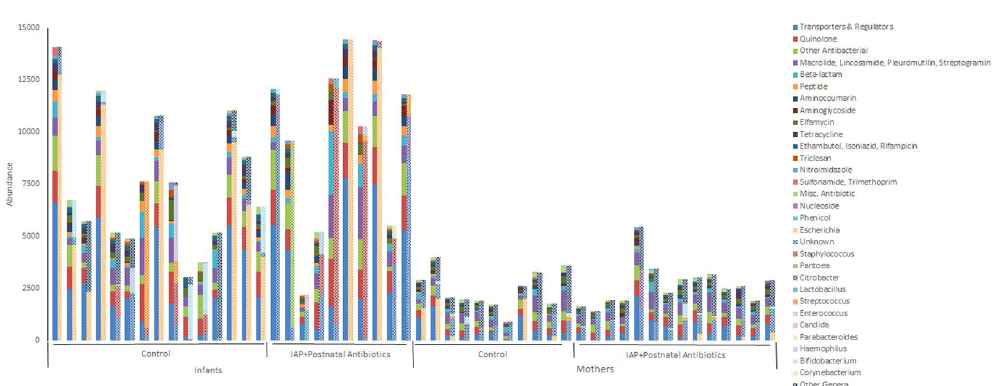
Figure 7. Gut microbiota and antimicrobial resistance (AMR) gene distribution of metagenomic samples. For each sample, the abundance of AMR genes is shown grouped by AMR class (solid stacked bars) next to their corresponding AMR encoding bacterial taxa (patterned stacked bars). Category Other Genera include 45 bacterial taxa. The y-axis presents the abundance or normalized counts based on the coverage of sequence reads and scaffold